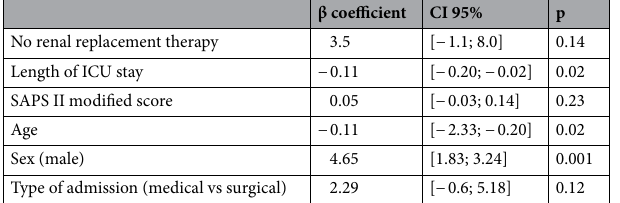
β coefficient CI 95%